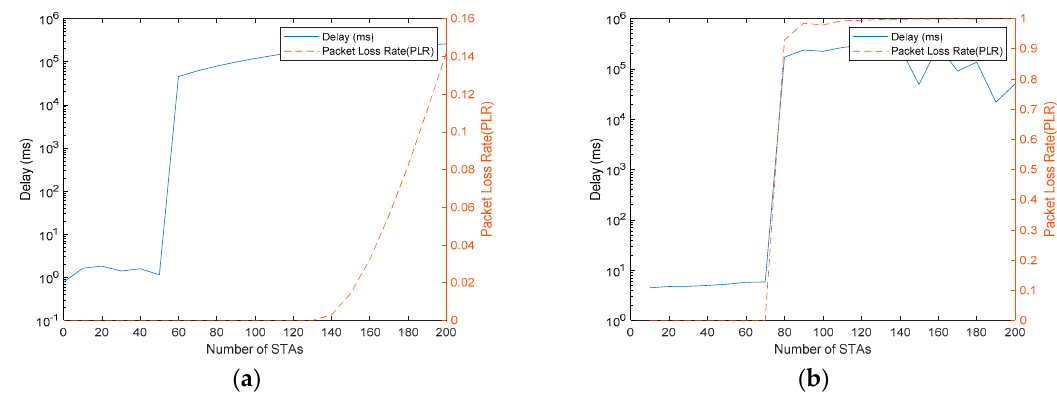
Figure 14. Average delay and PLR in a single band transmission with 30 sensor STAs: ( a ) Conventional IEEE 802.11p channel access scenario; ( b ) Proposed V2X-UORA channel access scenario with the dedicated RU method.